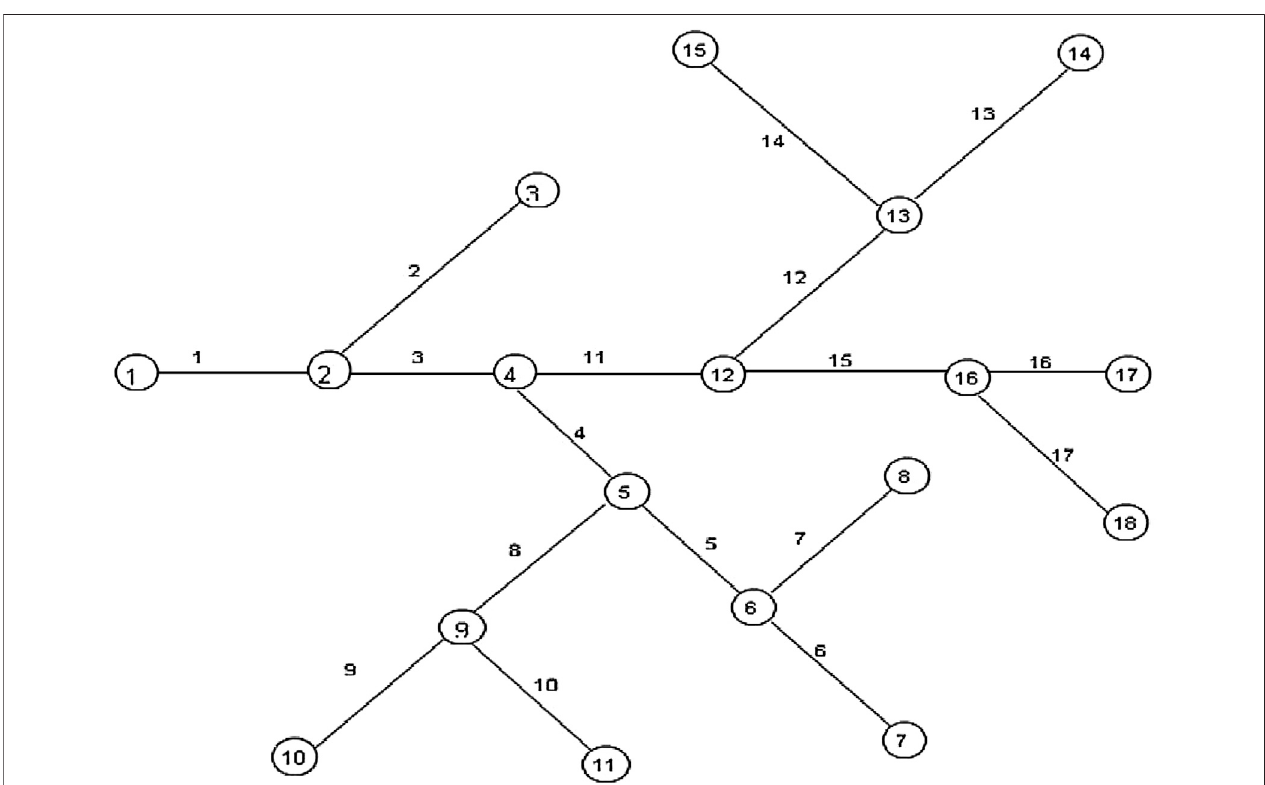
FIGURE 4 | Example network showing GBVP in nested